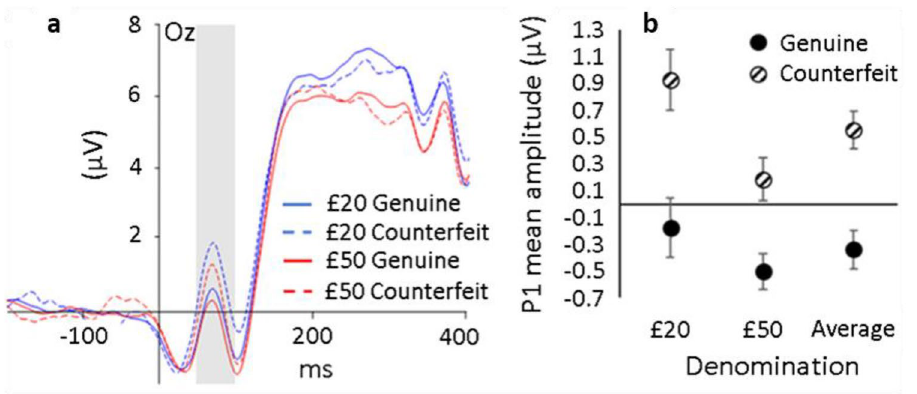
Figure 1. ( a ) Group mean amplitude (µV) of the ERP for each denomination and authenticity at electrode location Oz (where P1 was measured) plotted as a function of time relative to banknote presentation onset (0 ms). Blue and red lines represent £20 and £50 note conditions, respectively. Solid and dashed lines represent genuine and counterfeit banknote conditions, respectively. Positive is plotted up. The shaded rectangle indicates the time interval for P1. ( b ) Group mean amplitude at the P1 component plotted for each authenticity and denomination (including the average of each denomination). Error bars represent ± 1 within-subject S.E of the mean 30